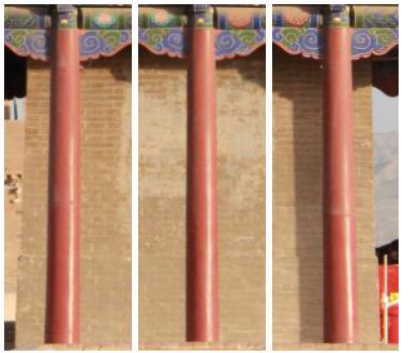
Figure 6. A scene picture of the columns on the first floor